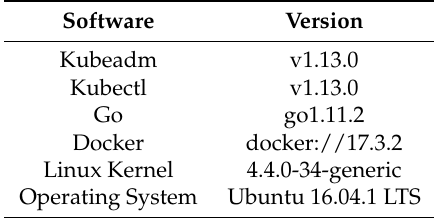
Table 3. Software Versions of the Evaluation